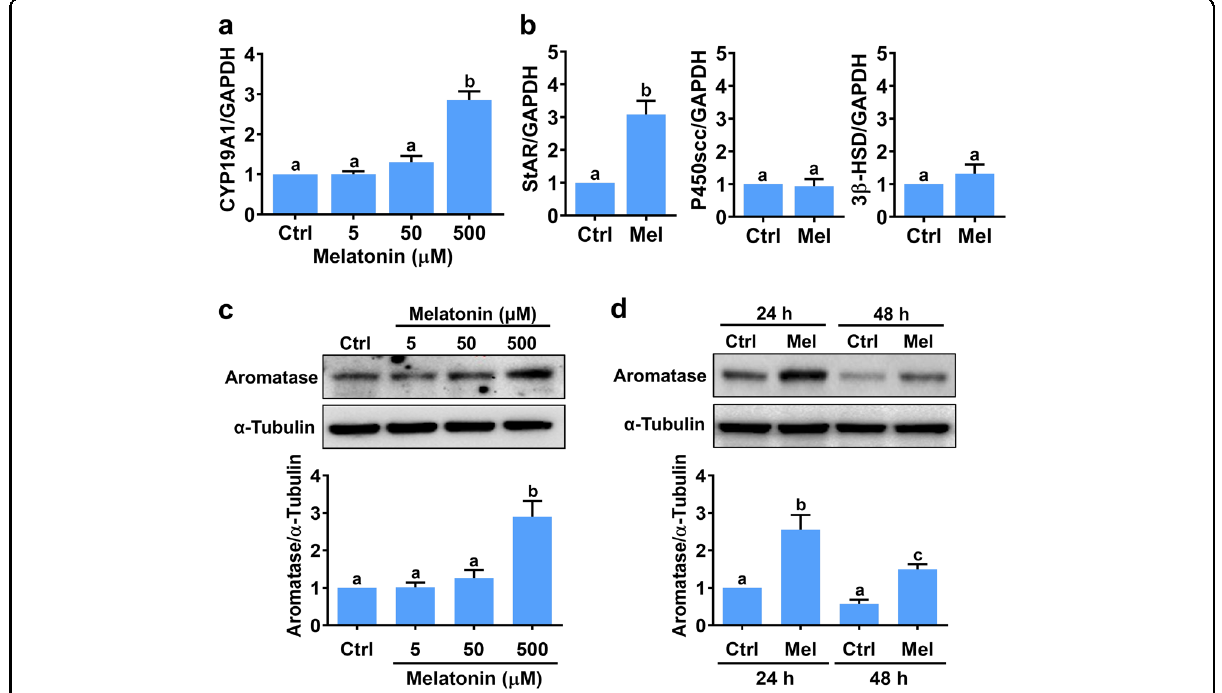
Fig. 1 Melatonin stimulates aromatase expression in primary human granulosa-lutein cells. a Cells were treated with different concentrations of melatonin (Mel) for 24 h, and aromatase mRNA levels (CYP19A1) were examined by RT-qPCR. b Cells were treated with 500 µM melatonin (Mel) for 24 h, and the mRNA levels of StAR, P450scc, and 3 β -HSD were examined by RT-qPCR. c Cells were treated with different concentrations of melatonin (Mel) for 24 h, and aromatase protein levels were examined by western blotting. d Cells were treated with 500 µM melatonin (Mel) for 24 or 48 h, and aromatase protein levels were examined by western blotting. The results are expressed as the mean ± SEM of at least three independent experiments. Values without a common letter are signi fi cantly different ( p <